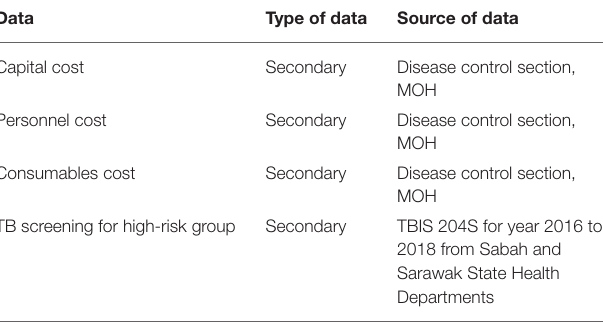
TABLE 1 | Source of